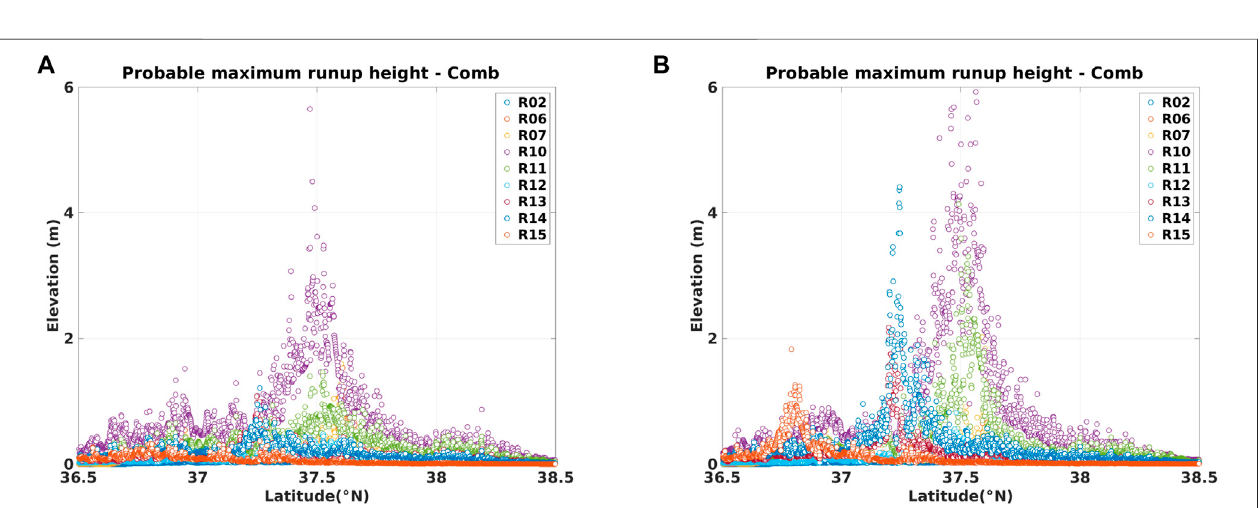
FIGURE 11 | Probable maximum runup height along the eastern coast of the Korean Peninsula estimated from modeling using Green ’ s law for 11 scenarios ( “ R ” ) and 2 combinations [ (A) : Combination A; (B) : Combination B] of fault parameters.